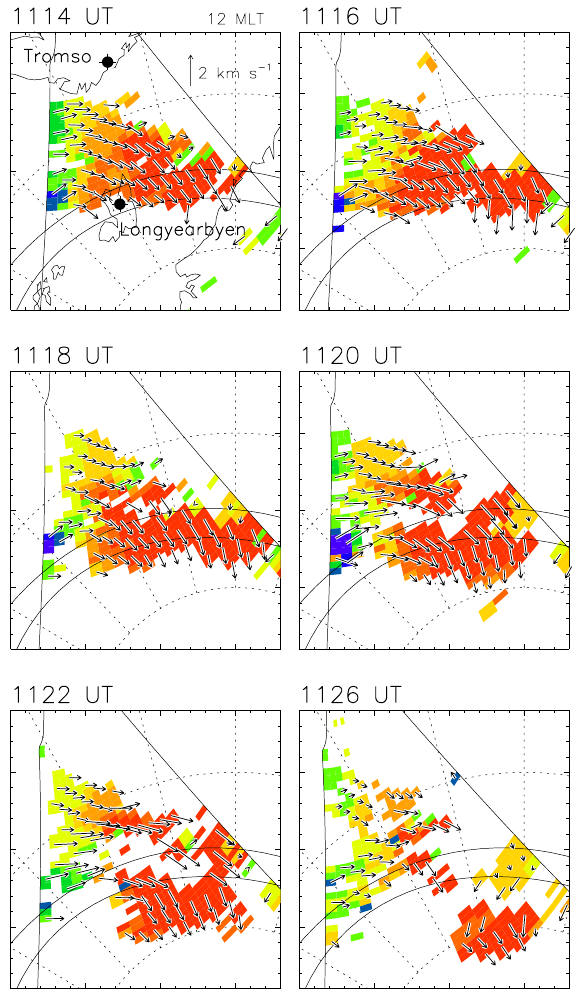
Fig. 7. A sequence of six radar scans, with superimposed beam- swung vectors, showing the interval during which the 1 September 1999 polar patch was